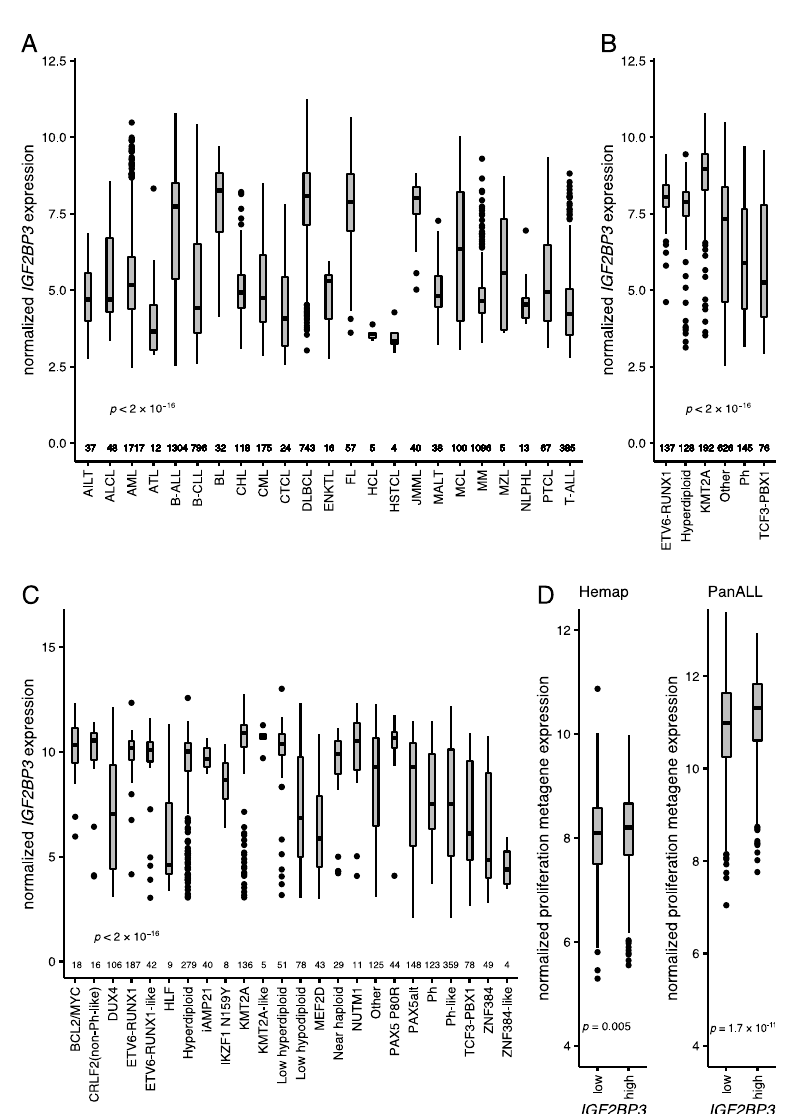
Figure 3. Expression of IGF2BP3 across different hematological malignancies and subtypes of B-ALL. ( A ) IGF2BP3 expression in the Hemap data set in different hematological malignancies ( n = 6832) [24,25]. ( B ) IGF2BP3 expression in different cytogenetic subtypes of B-ALL ( n = 1304) in the Hemap data set [24,25]. ( C ) IGF2BP3 expression in different B-ALL subtypes of B-ALL in the PanALL study cohort ( n = 1988) [26]. ( D ) Proliferation-associated “metagene” [33] expression in B-ALL in the Hemap and PanALL data sets (median as a cut-off for the IGF2BP3 expression groups). AILT—angioimmunoblastic T-cell lymphoma; ALCL—anaplastic large cell lymphoma; AML—acute myeloid leukemia;